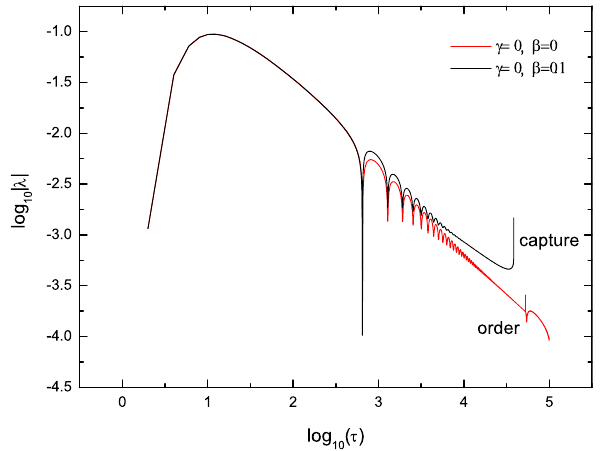
Fig. 3 Thecorresponding maximumLyapunovexponentsofthestring trajectory shown in Figs. 1 and